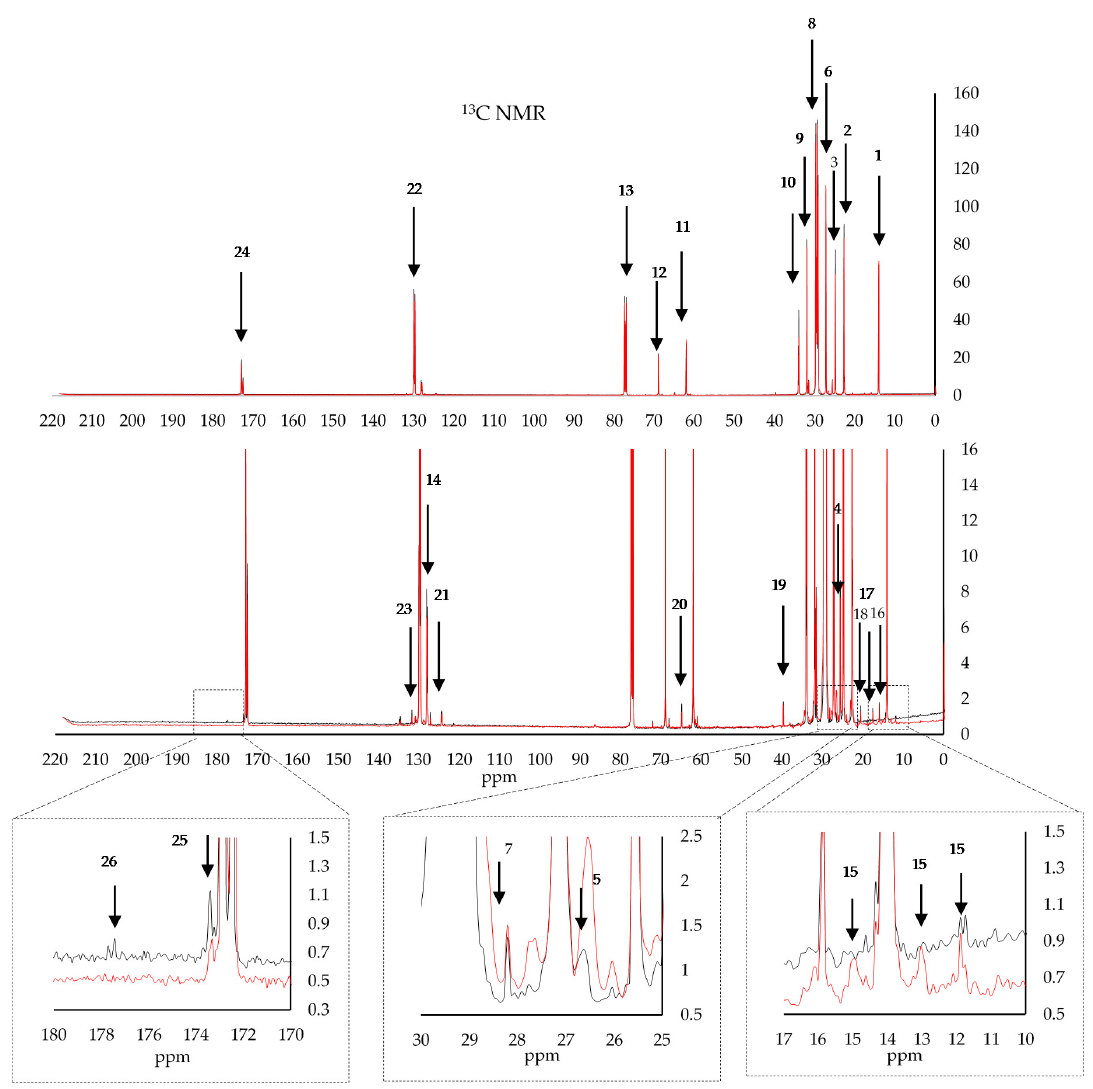
Figure 2. The major peaks of interest obtained using the 13 C NMR of EVOOs (black line Maltese EVOOs, red line non-Maltese EVOOs).